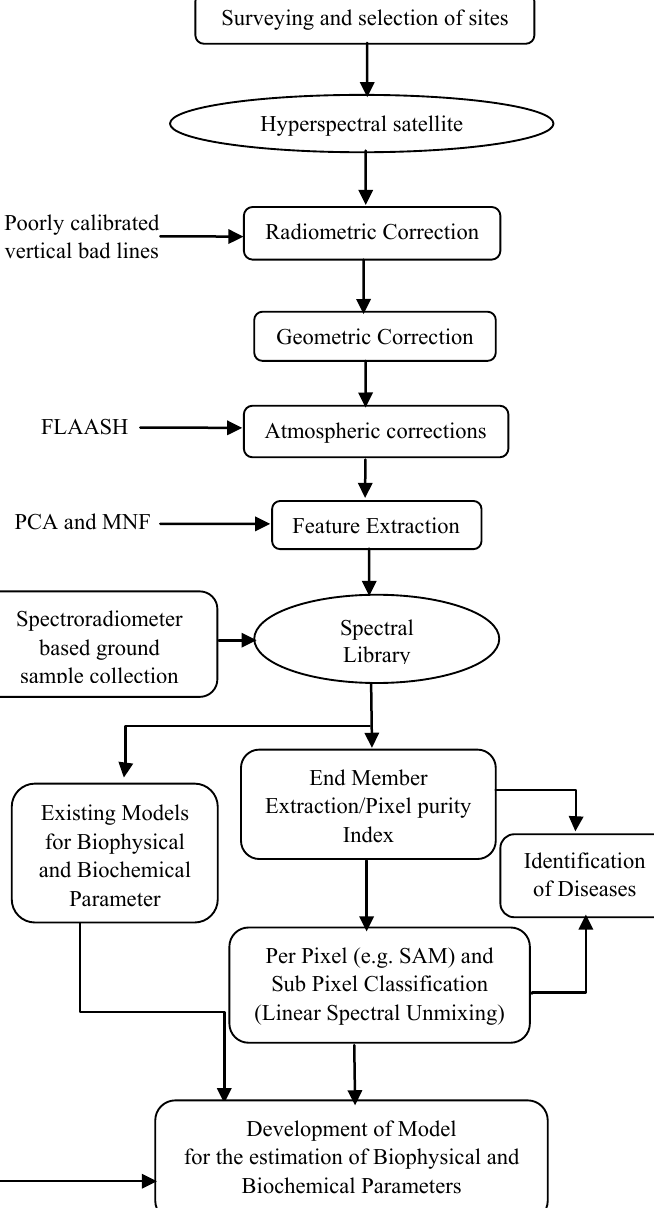
Figure 3: Methodology for the processing of hyperspectral data At a very first step, to generate the reference data surveying of sites and identification of temperate horticulture crop plots of suitable size is necessary. This will be carried out by selecting appropriate hyper spectral satellite data. Processing of hyper spectral imagery is a challenging task. For poorly calibrated vertical bad lines radiometric correction needs to be applied. For atmospheric correction techniques such as Fast